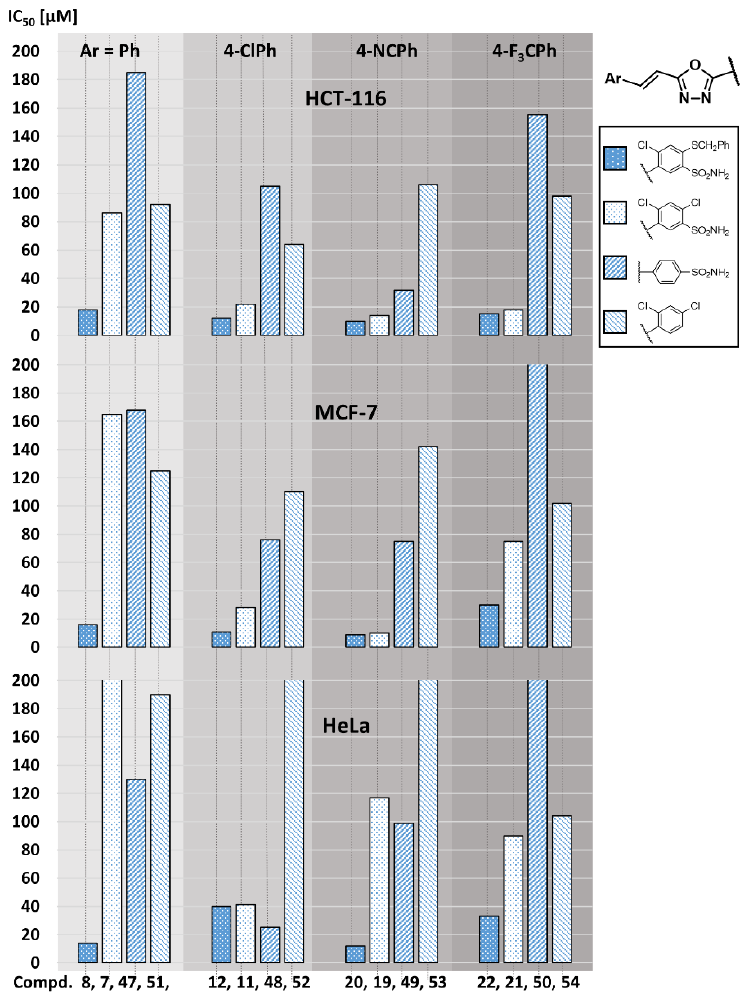
Figure 3. Comparison of cytostatic activity of compounds with the same Ar substituent but differing in main scaffold: 2-(benzylthio)-4-chlorobenzenesulfonamide ( 8 , 12 , 20 , 22 ), 2,4-dichlorobenzenesulfonamide ( 7 , 11 , 19 , 21 ) 4-benzenesulfonamide ( 47 – 50 ) and 2,4-dichlorobenzene ( 51 – 54 ).